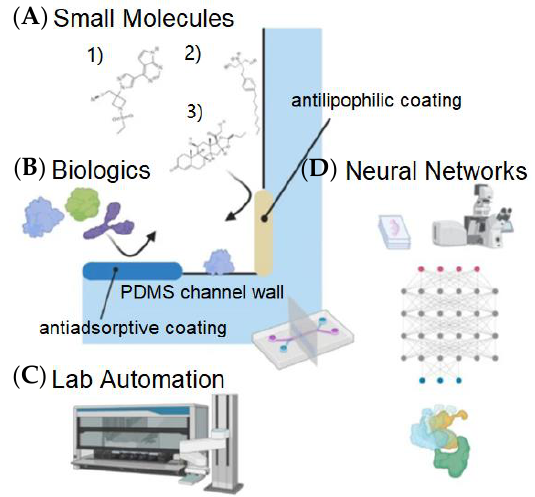
Figure 7. Application of deep learning in lung-on-a-chip and upcoming advances. This figure is directly reproduced from the corresponding paper [67]. ( A ) Small lipophilic molecules bind to surfaces such as PDMS channel walls and can be characterized by the Langmuir–Freundlich isotherm. ( B ) Biologics such as antibodies and recombinant proteins adsorb to PDMS channel walls. ( C ) Integrating lung-on-a-chip with automated liquid handling and continuous flow. ( D ) AI algorithms such as NNs can aid drug discovery through molecular docking and design, image analysis, and toxicity predictions. Reproduced with permission from Springer Nature Copyright (2023).